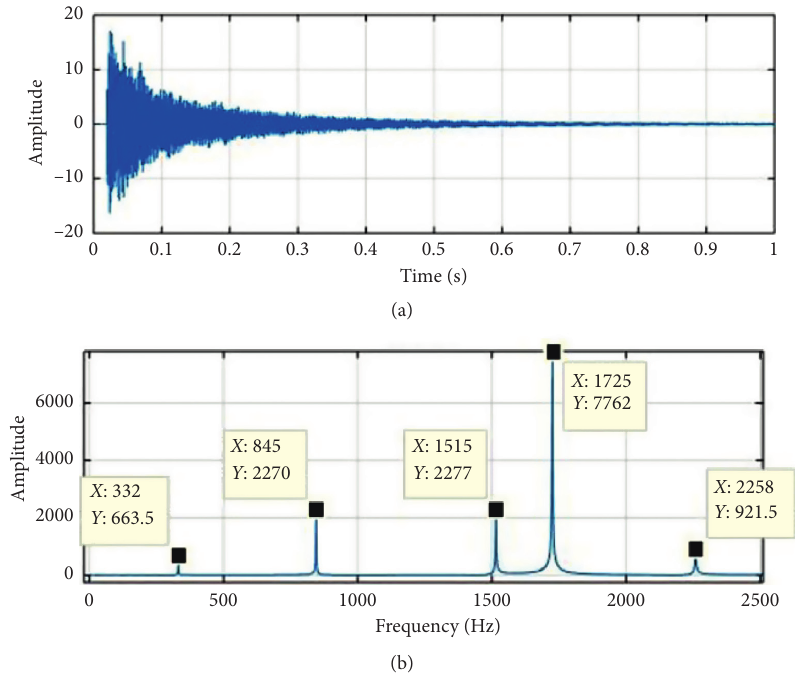
Figure 12: The response signal and its frequency spectrum in hammer detection. (a) The response signal. (b) The frequency spectrum of the response signal.